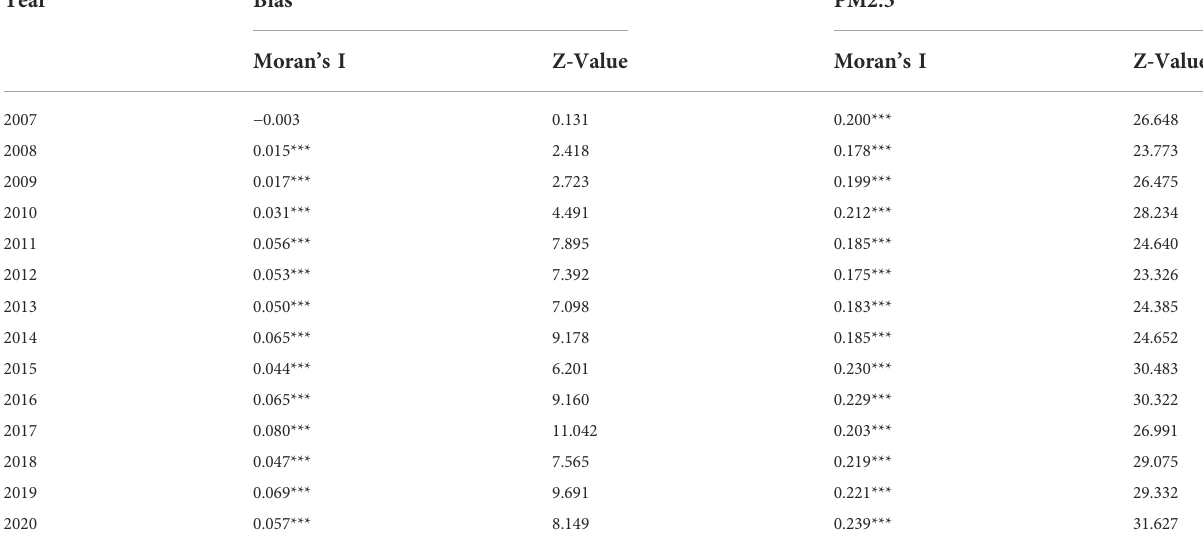
TABLE 2 Moran ’ s I for